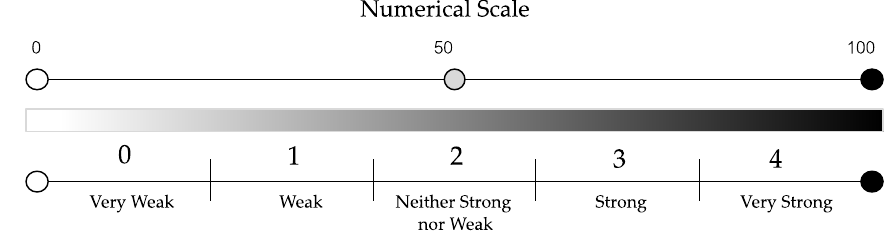
Figure 2. Division of the scale.